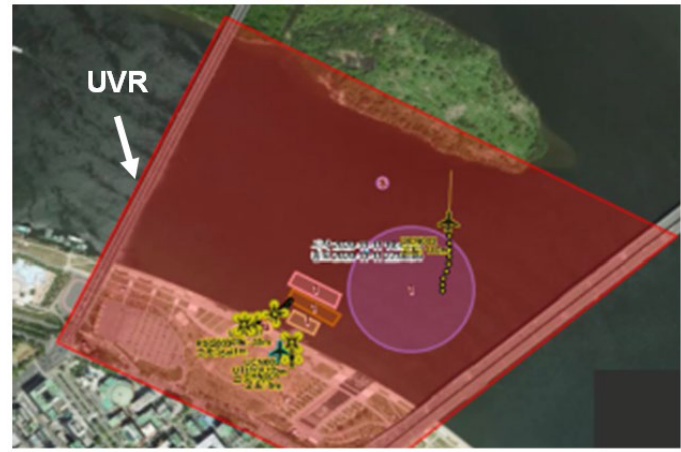
Figure 5. Issuance of UVR (red section).